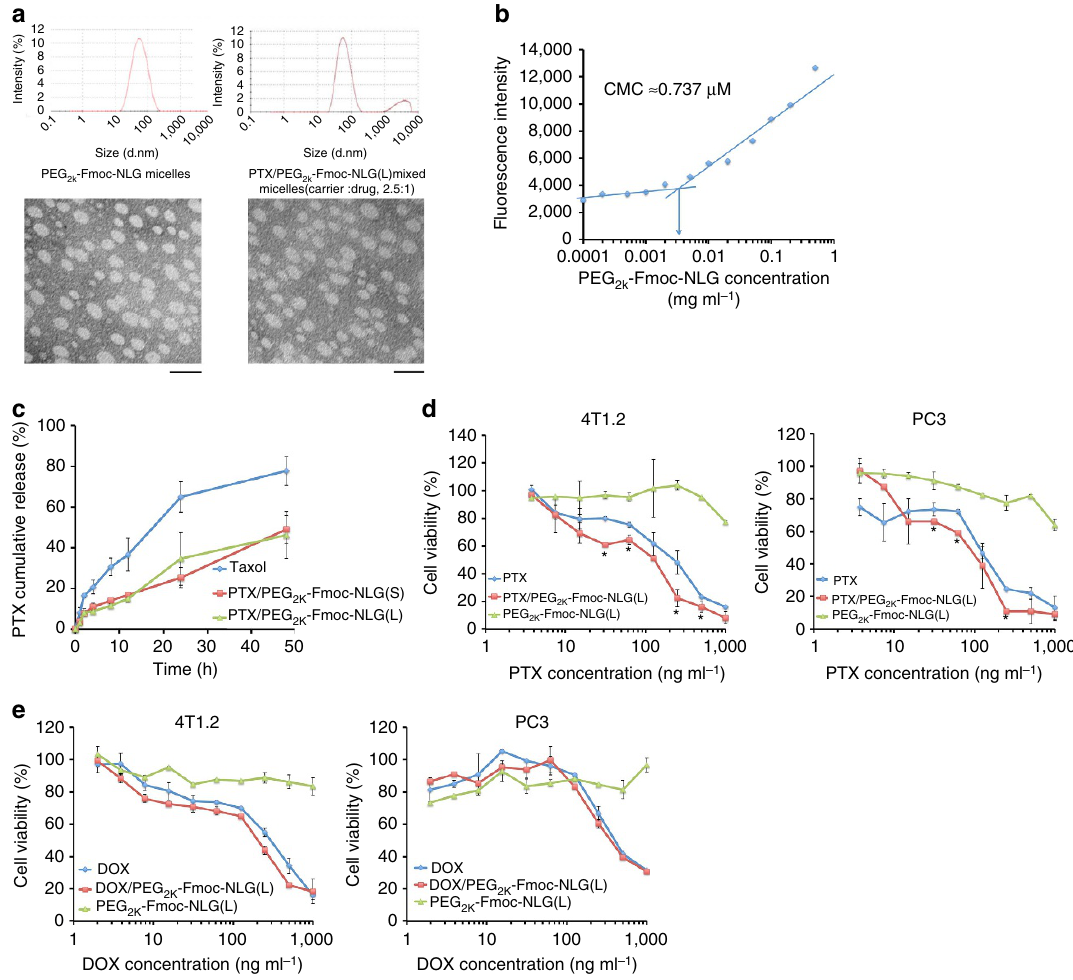
Figure 3 | In vitro biophysical and biological characterizations of micelles. ( a ) Size distribution and morphology of drug-free and PTX-loaded PEG 2k - Fmoc-NLG(L) micelles (carrier: drug, 2.5:1, m/m) were examined by dynamic light scattering and TEM, respectively. Drug concentration in micelles was kept at 1mgml (cid:2) 1 . Blank micelle concentration was 20mgml (cid:2) 1 . Scale bar, 100nm. ( b ) Measurement of CMC of PEG 2k -Fmoc-NLG(L) micelles. ( c ) PTX release kinetics of PTX/PEG 2k -Fmoc-NLG(L) examined via a dialysis method. PTX concentrations were kept at 1mgml (cid:2) 1 in PTX/PEG 2k -Fmoc-NLG(S), PTX/PEG 2k -Fmoc-NLG(L) and Taxol. PTX concentrations were analysed at 0, 1, 2, 4, 8, 24 and 48h by HPLC. ( d ) Cytotoxicity of PEG 2k -Fmoc-NLG(L) alone, free PTX, and micellar PTX against a mouse breast cancer cell line (4T1.2) and a human prostate cancer cell line (PC3). Cells were treated for 72h and cytotoxicity was determined by MTT assay. * P o 0.05 (PTX/PEG 2k -Fmoc-NLG(L) versus PTX), N ¼ 3. ( e ) Cytotoxicity of PEG 2k -Fmoc-NLG(L) alone, free DOX, and micellar DOX against a mouse breast cancer cell line (4T1.2) and a human prostate cancer cell line (PC3). Data represent means ± s.e.m.